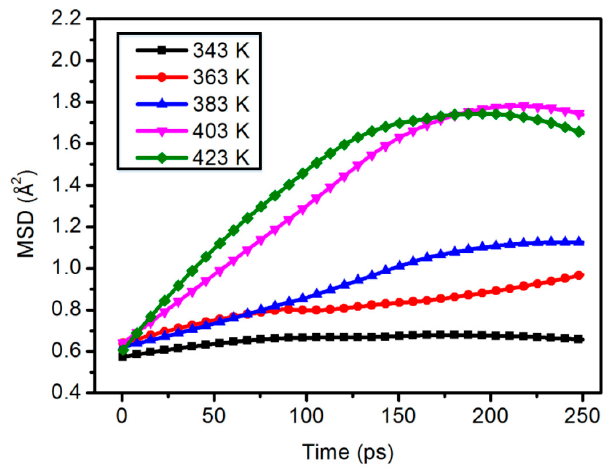
Figure 6. Chain motion of the 2.5 wt % content composite model.